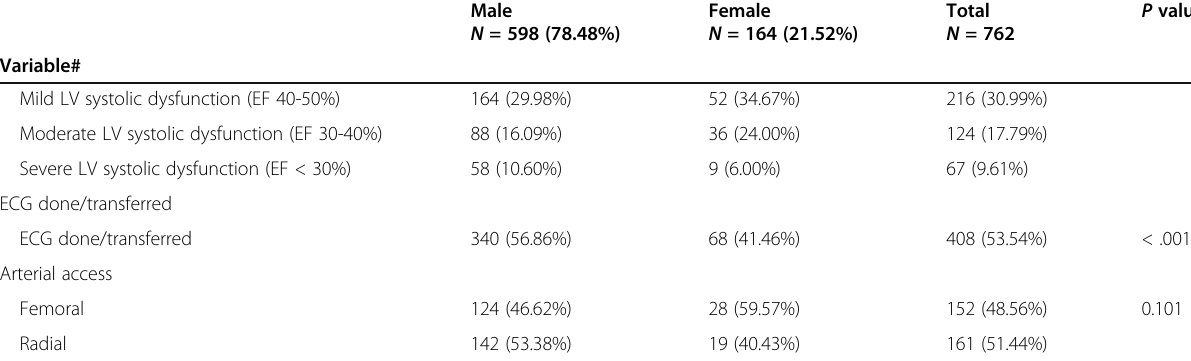
Table 1 Epidemiological data and presentation characteristics of NSTEMI patients by gender